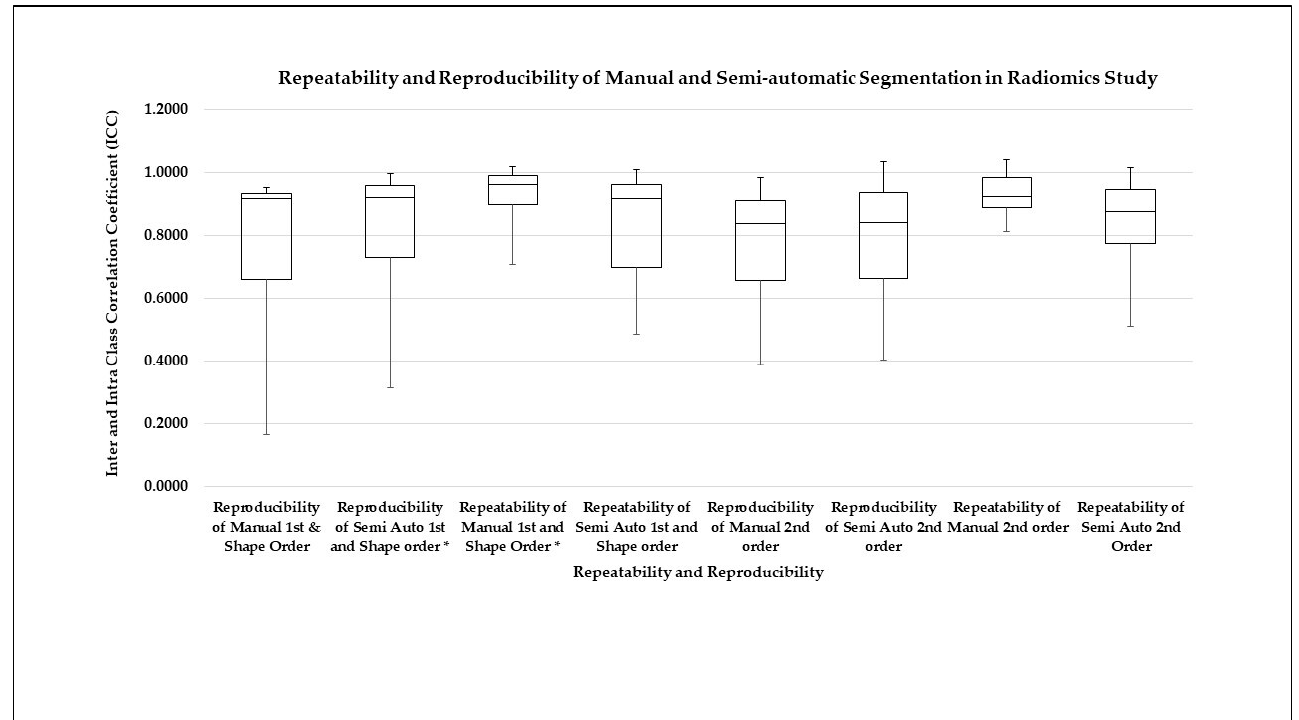
Figure 10. Repeatability and reproducibility of manual and semi-automatic segmentation for the first-, shape and second-order features. The (*) shows the highest repeatability and reproducibility mean score with a significant p -value ( p <